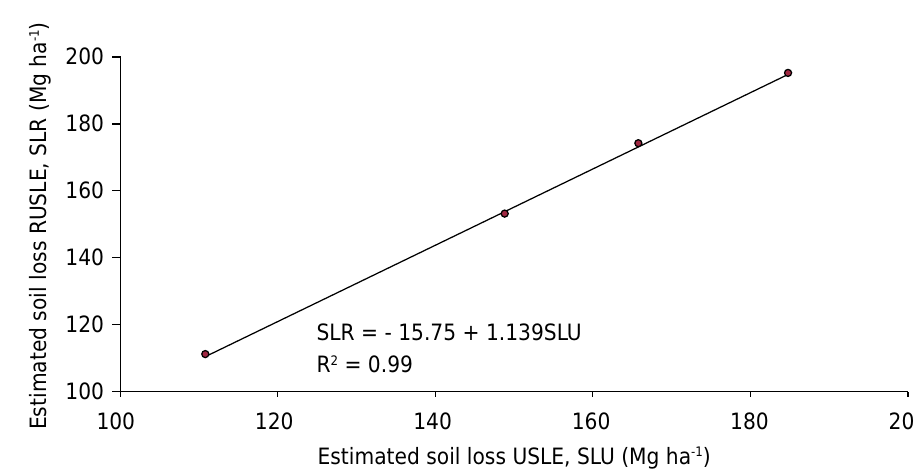
Figure 6. Relation between values of soil loss estimated by the RUSLE (SLR) and estimated by the USLE (SLU) in each treatment (average of